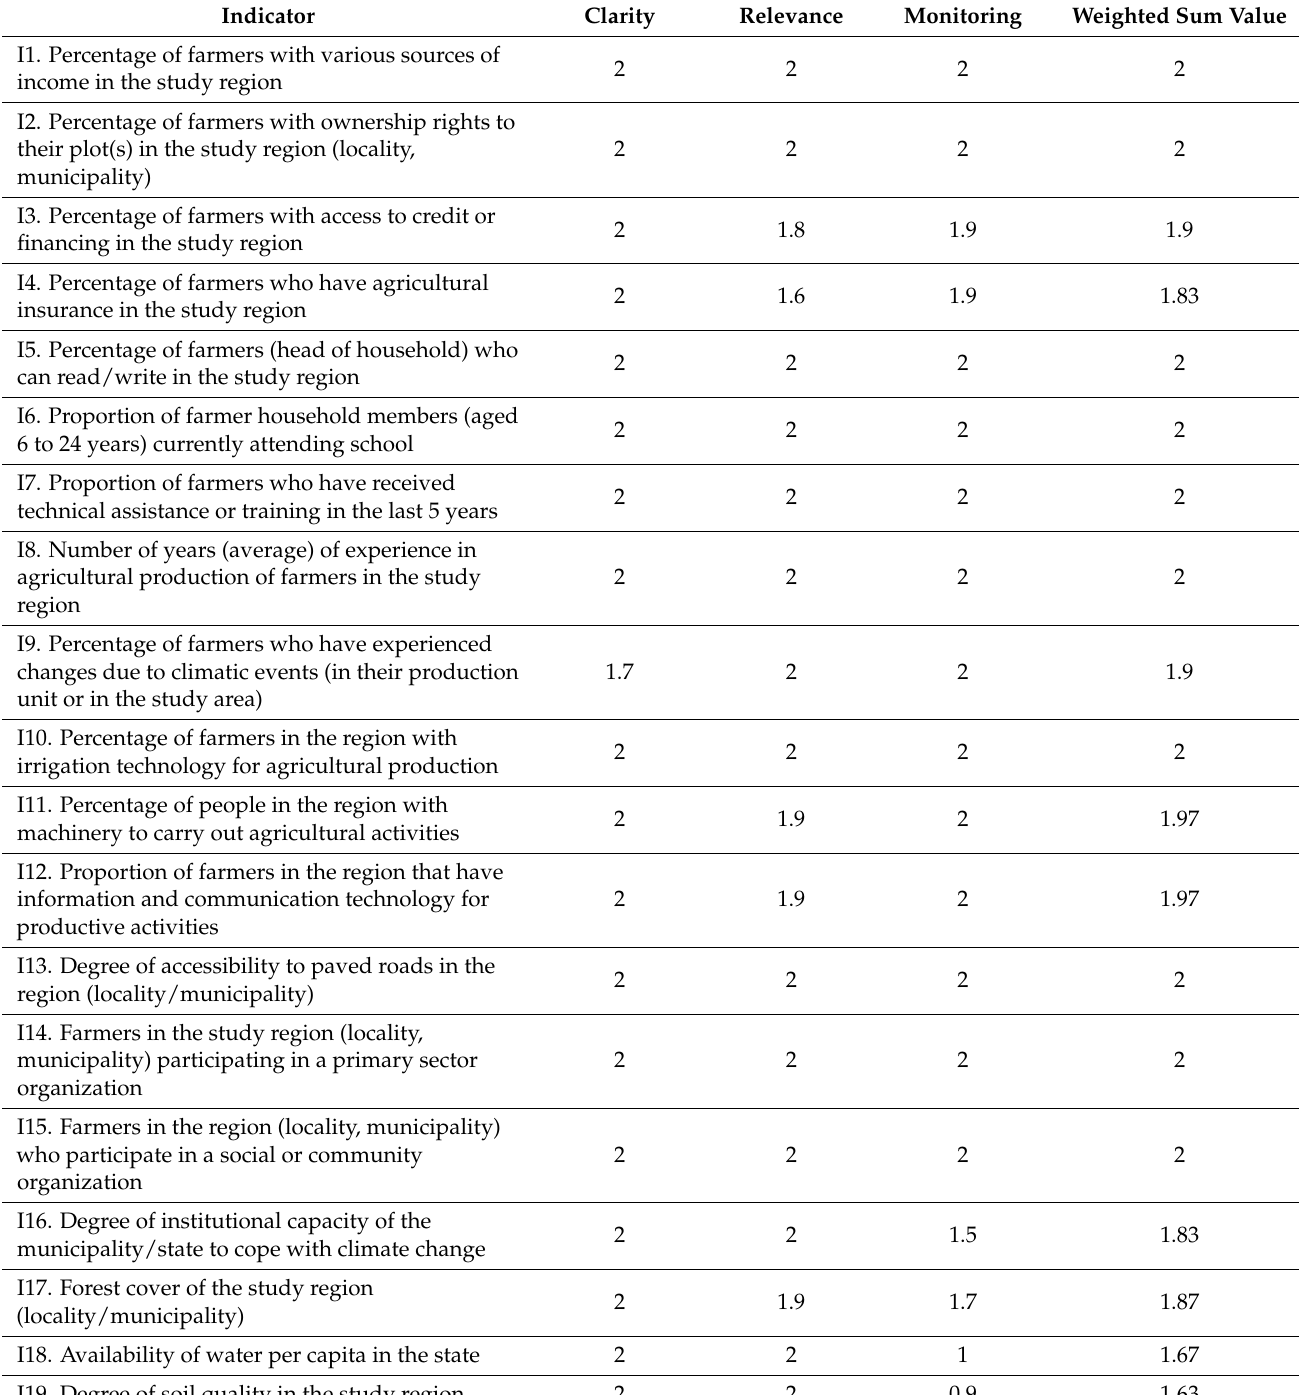
Table 2. Weighted values obtained for each